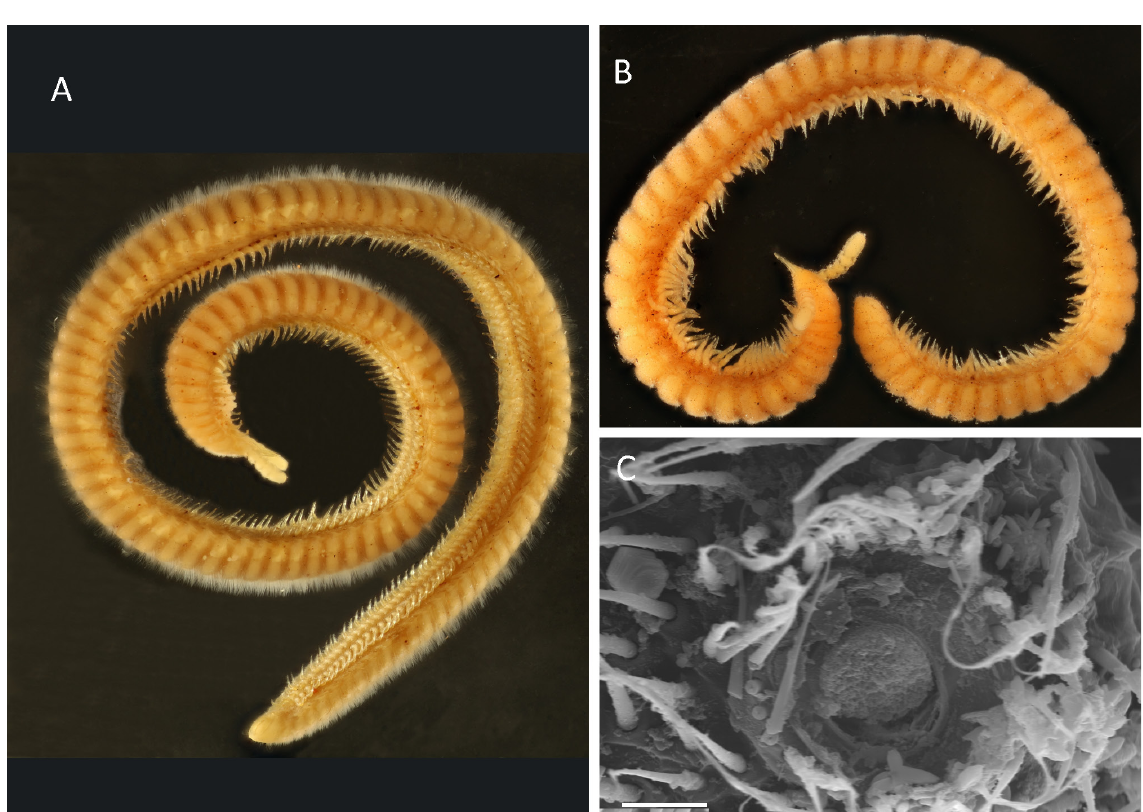
Fig. 8. A . Siphonophora fuhrmanni Carl, 1914, type specimen, habitus, body length approximately 30 mm. B . Siphonophora mjoebergi Verhoeff, 1924, non-type specimen, habitus, body length approximately 15 mm. C . Siphonophora setaepromissa sp. nov., paratype, ozopore showing ring of setae, scale bar = 0.01